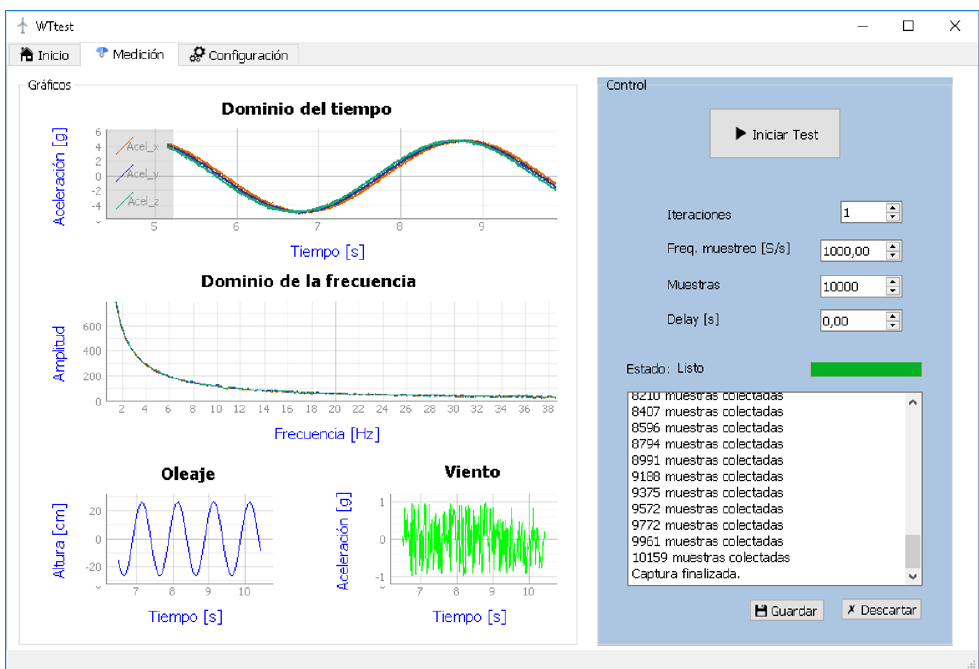
Figure 11. Simulation for the application DAQ.